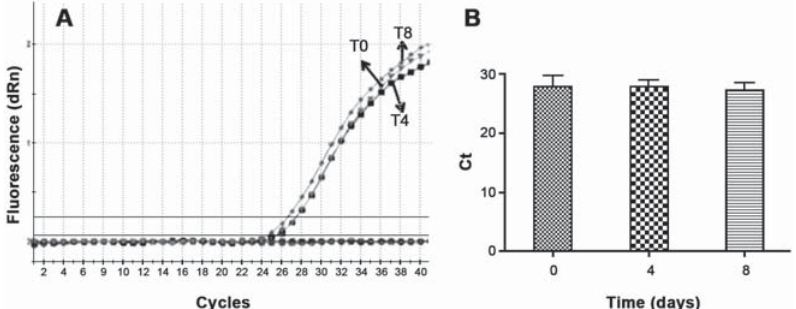
Figure 3- (cid:2)(cid:3)(cid:4)(cid:5)(cid:6)(cid:7)(cid:8)(cid:9)(cid:10)(cid:5)(cid:11)(cid:2)(cid:6)(cid:12)(cid:2)(cid:13)(cid:14)(cid:15)(cid:16)(cid:2)(cid:17)(cid:18)(cid:19)(cid:20)(cid:21)(cid:22)(cid:20)(cid:23)(cid:24)(cid:20)(cid:23)(cid:25)(cid:2)(cid:9)(cid:6)(cid:26)(cid:8)(cid:27)(cid:6)(cid:18)(cid:9)(cid:28)(cid:10)(cid:19)(cid:27)(cid:2)(cid:29)(cid:8)(cid:2)(cid:18)(cid:4)(cid:30)(cid:26)(cid:2)(cid:7)(cid:10)(cid:27)(cid:4)(cid:2)(cid:9)(cid:6)(cid:26)(cid:8)(cid:27)(cid:4)(cid:18)(cid:30)(cid:19)(cid:4)(cid:2)(cid:31)(cid:28)(cid:30)(cid:10)(cid:5)(cid:2)(cid:18)(cid:4)(cid:30)(cid:31)(cid:7)(cid:10)(cid:6)(cid:5)(cid:2)(cid:17)!"(cid:14)(cid:25)#(cid:2)$(cid:25)(cid:2)(cid:30)(cid:27)(cid:9)(cid:26)(cid:10)%(cid:31)(cid:30)(cid:7)(cid:10)(cid:6)(cid:5)(cid:2) plot of the same DNA in different time incubation and B) mean Ct values in different time incubation